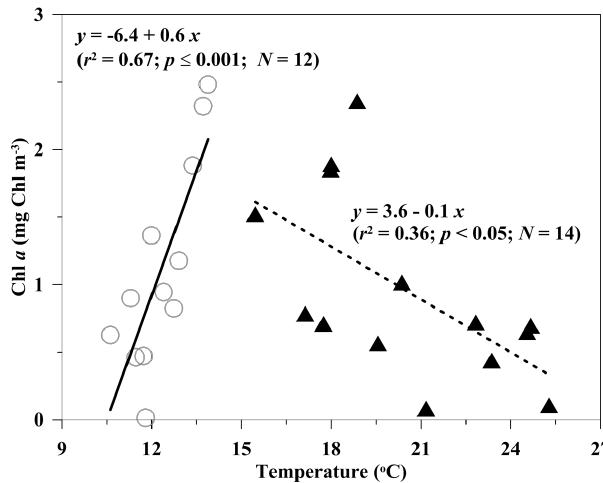
Fig. 6. Relationship between Chl a and temperature in the surface waters in the spring of 2010. Linear regressions between Chl a vs. temperature < 15 ◦ C ( (cid:13) ; solid line) or temperature = 15 ◦ C ( N ; dashed line) with r 2 and p are also